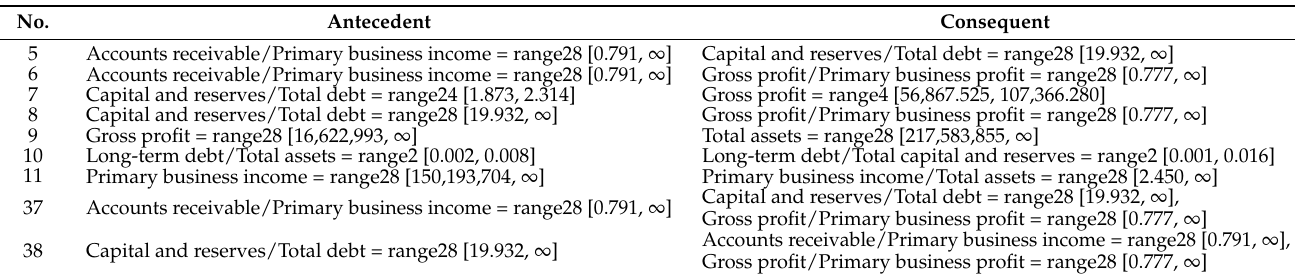
Table 6. Fraud patterns from financial statement